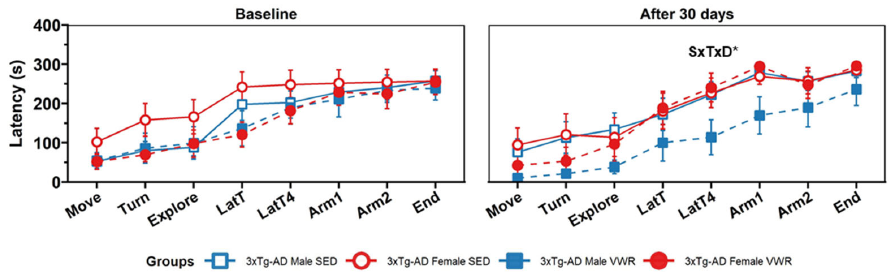
Figure 4. TMSA test at baseline ( left ) and after 30 days follow ‐ up ( right ). Latency to move (Move),